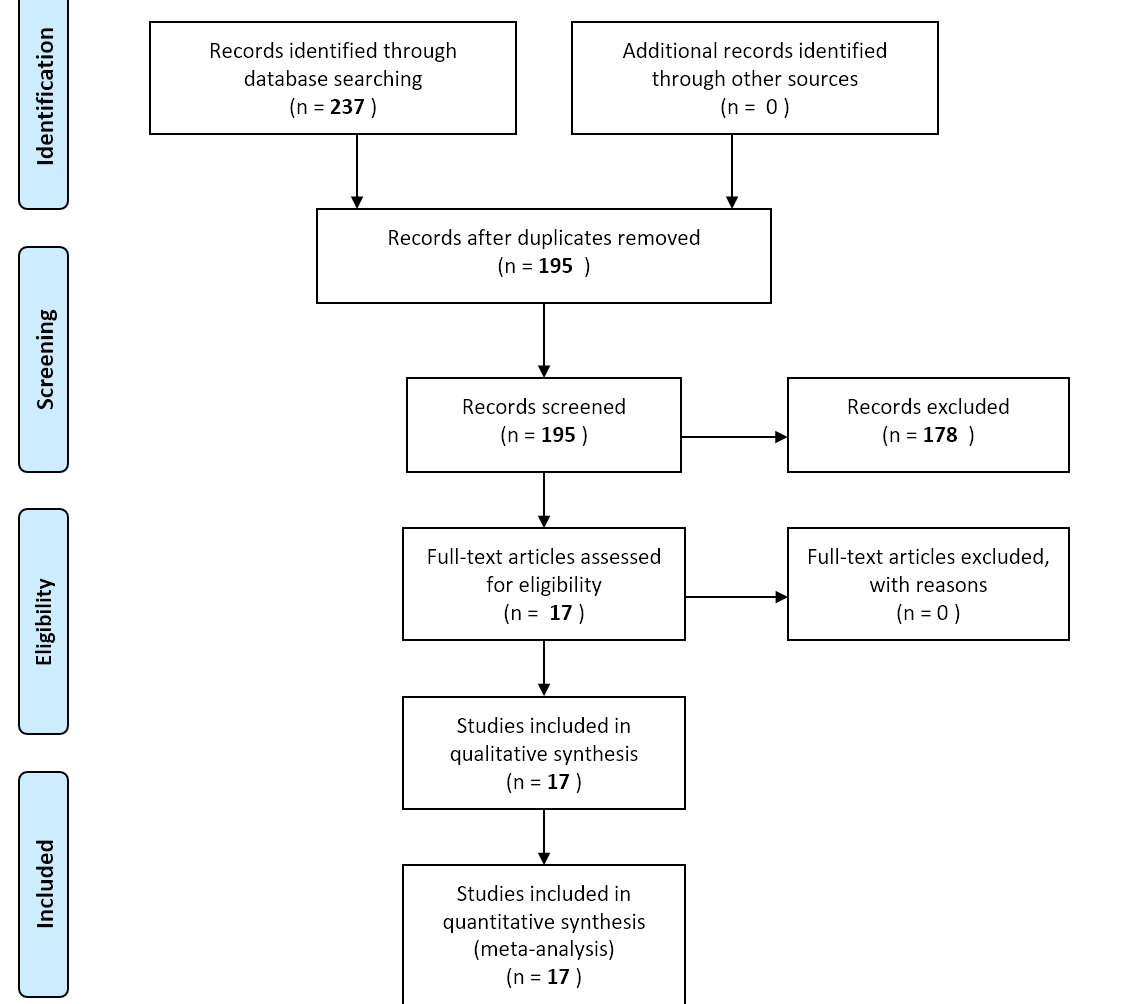
Figure 3. Information flow through the phases of the systematic review. PRISMA Flow Diagram adapted from Moher et al.